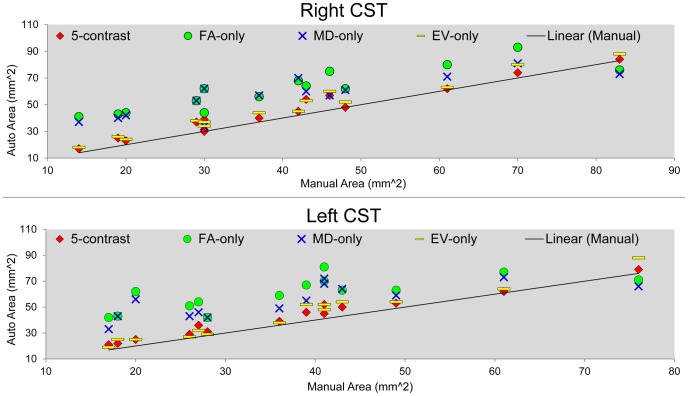
A comparison of the CST correlation obtained from using a single-contrast image and multi-contrast images.A correlation plot between the automated and manual measurements of the sizes of left and right corticospinal tracts (CST). Results from the four automated parcellation methods are compared: 5-contrast (red), FA-only (green), MD-only (blue), and EV-only (yellow).